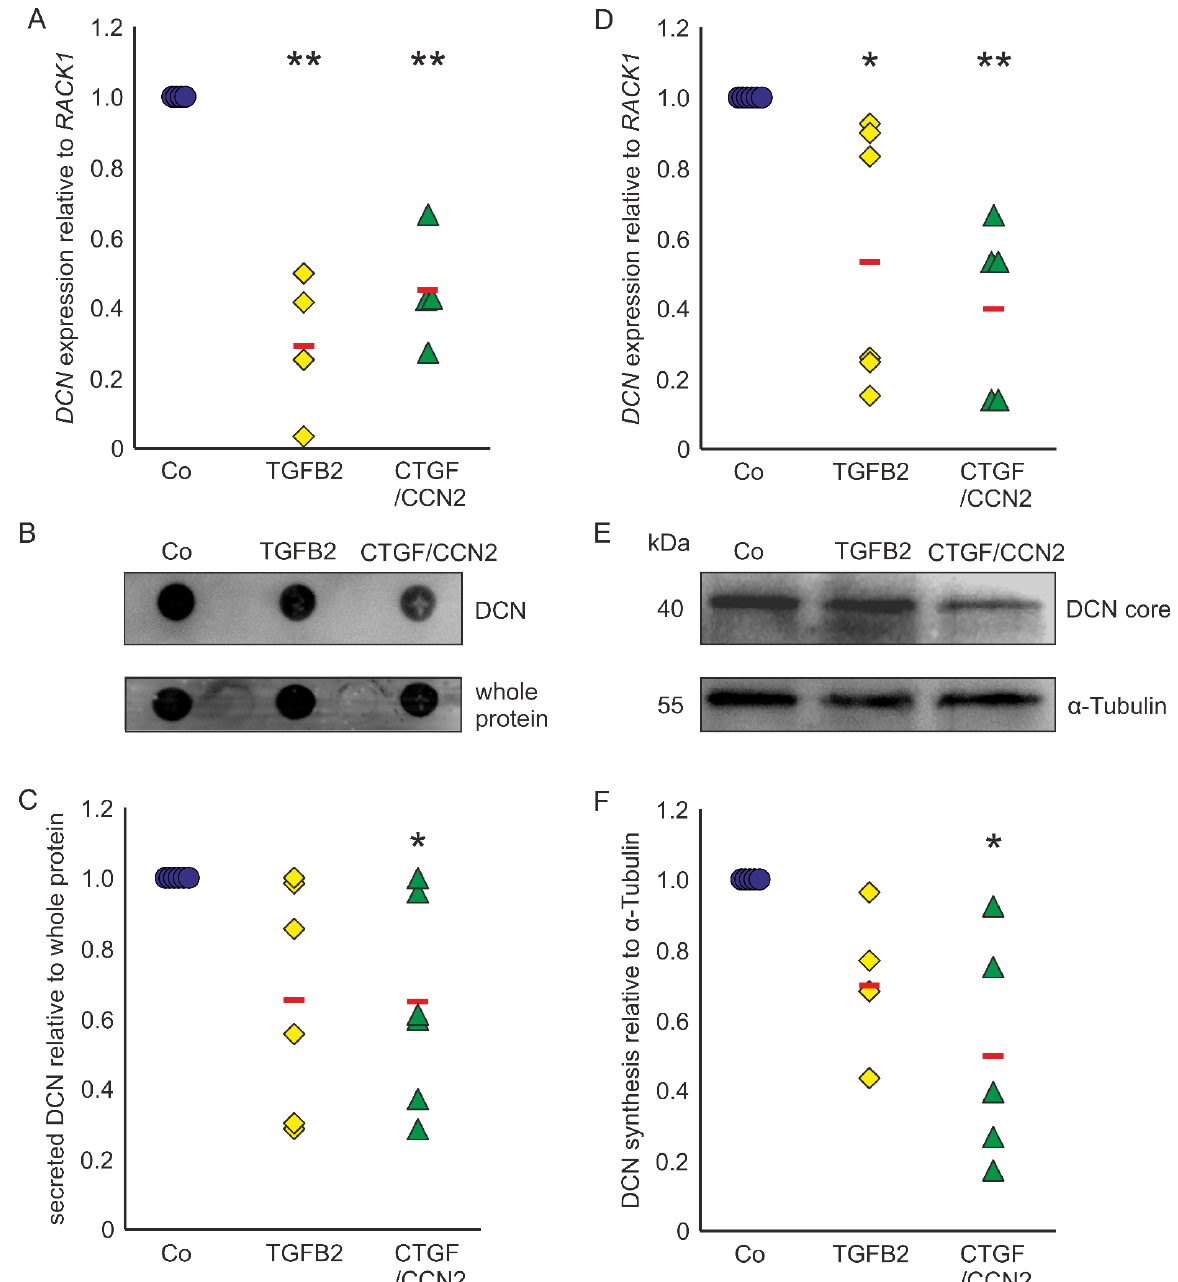
Figure 3. TGF- β and CTGF/CCN2 negatively regulate DCN in murine ON astrocytes (left) and human ONH astrocytes (right). ( A ) Treatment with TGF- β 2 reduced DCN mRNA to 0.29 ± 0.22 ( n = 4, p = 0.0003) and treatment with CTGF/CCN2 reduced DCN expression to 0.45 ± 0.16 ( n = 4, p = 0.0019) in murine ON astrocytes. mRNA expression was normalized to RACK1 . Expression in untreated controls was set to 1. ( A ) In the medium of murine ON astrocytes secreted DCN levels were at 0.66 ± 0.31 ( n = 6, p = 0.089) after treatment with TGF- β 2, while CTGF/CCN2 treatment significantly reduced DCN synthesis to 0.65 ± 0.26 ( n = 6, p = 0.048). Secreted protein was normalized to whole protein, untreated controls were set to 1; ( B , C ). In human ONH astrocytes treatment with TGF- β 2 reduced DCN mRNA to 0.56 ± 0.37 ( n = 6, p = 0.0230) and treatment with CTGF/CCN2 reduced DCN expression to 0.40 ± 0.24 ( n = 5, p = 0.0072). mRNA expression was normalized to RACK1 . Expression in untreated controls was set to 1; ( D ) DCN protein levels were at 0.71 ± 0.11 ( n = 4, p = 0.1861) after treatment with TGF- β 2 (0.004 nM), while CTGF/CCN2 (3 nM) treatment significantly reduced DCN synthesis to 0.50 ± 0.18 ( n = 5, p = 0.0129) in human ONH astrocytes (protein synthesis was normalized to α -Tubulin, expression in untreated control cells was set to 1); ( E , F ). Co = Control. *, ** are significant with p ≤ 0.05 or p ≤